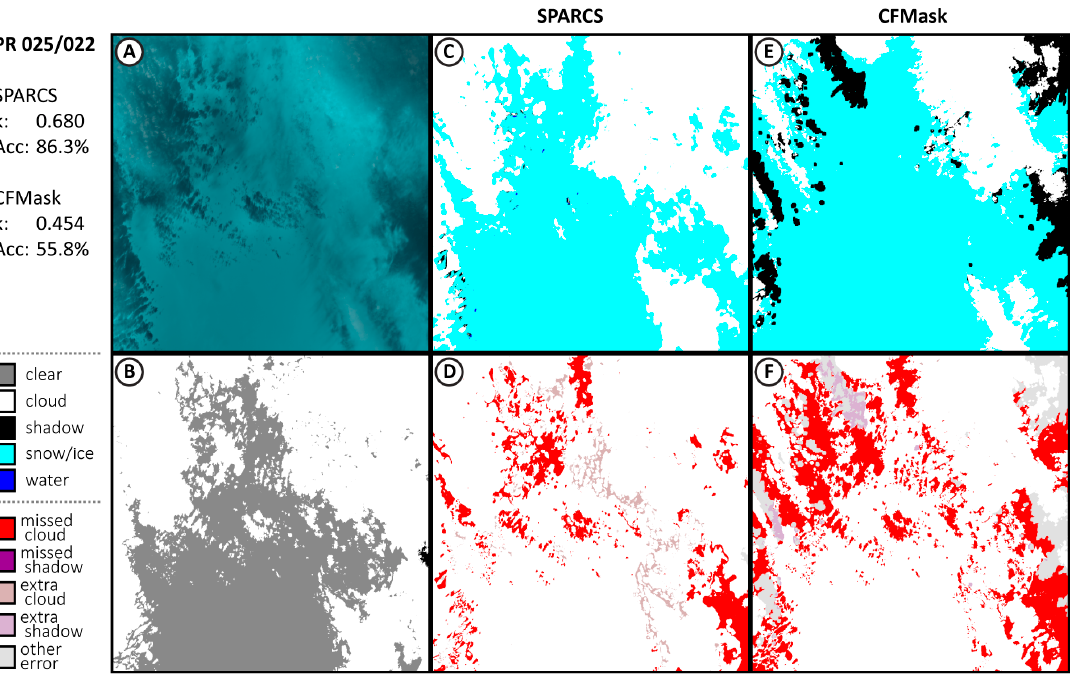
Figure A7. Results for Biome test image from PR 098/071, with false color image used during interpretation (A), the manually labeled interpretation (B), generated masks from SPARCS (C) and CFMask (E), and respective spatial distribution of errors (D, F).